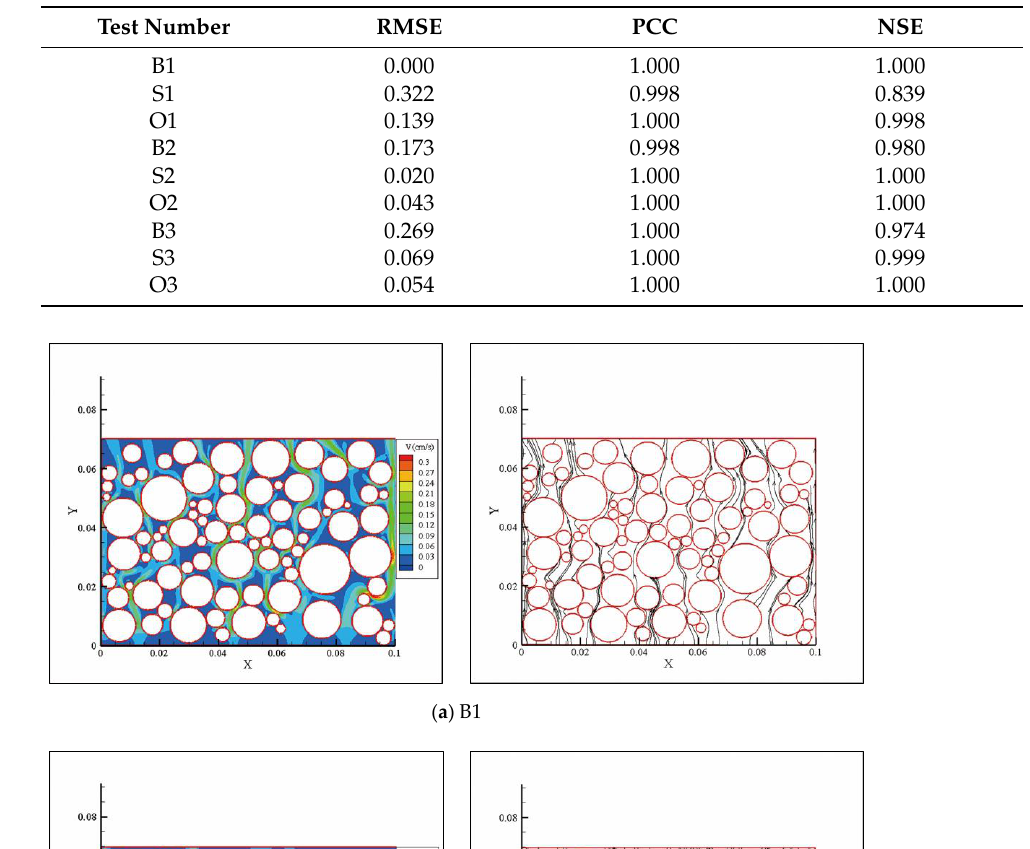
Table 5. Accuracy analysis of the simulation result.